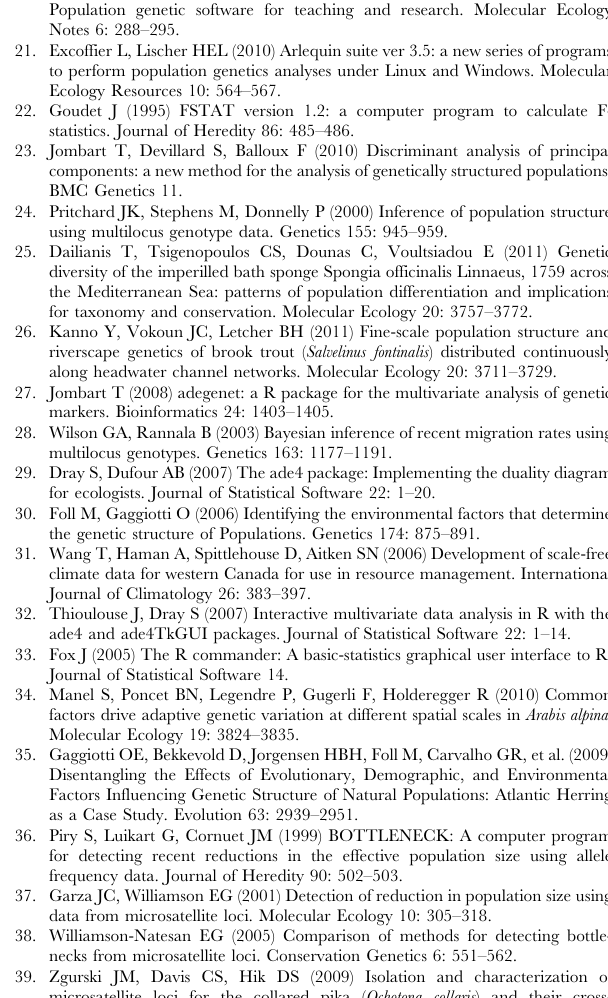
Table S2 Information on the microsatellite loci tested in the present study including locus name, Genbank numbers, length ( for successful amplification ) and PCR program ( for loci retained in the present study ) , the dye and multiload used. Loci with a single fragment length were monomorphic in our samples. Table S3 Tests of Hardy Weinberg equilibrium ( HWE ) within each site for each loci used. Black boxes indicate significant deviation from HWE per locus per site after corrections for multiple comparisons. Table S4 Test of linkage disequilibrium for each pair of loci calculated within sites. Combined p -values are given below the diagonal, and sites at which the two loci were linked are given above the diagonal. Table S5 Observed ( H O ) and expected ( H E ) heterozygos- ities for each locus and each site. (XLS)